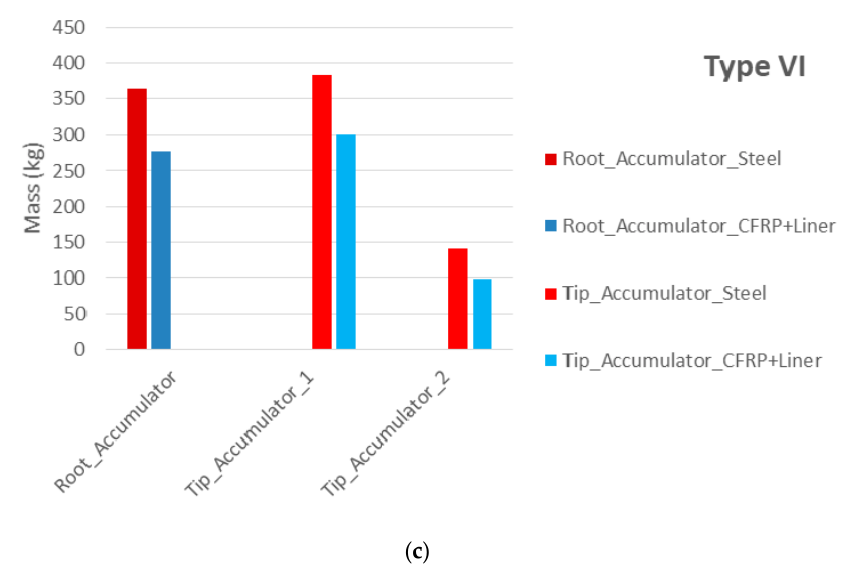
Figure 10. Mass comparison of blade tip and blade root accumulators from steel and from CFRP with steel liner for ( a ) type I, ( b ) type IV, and ( c ) type VI.